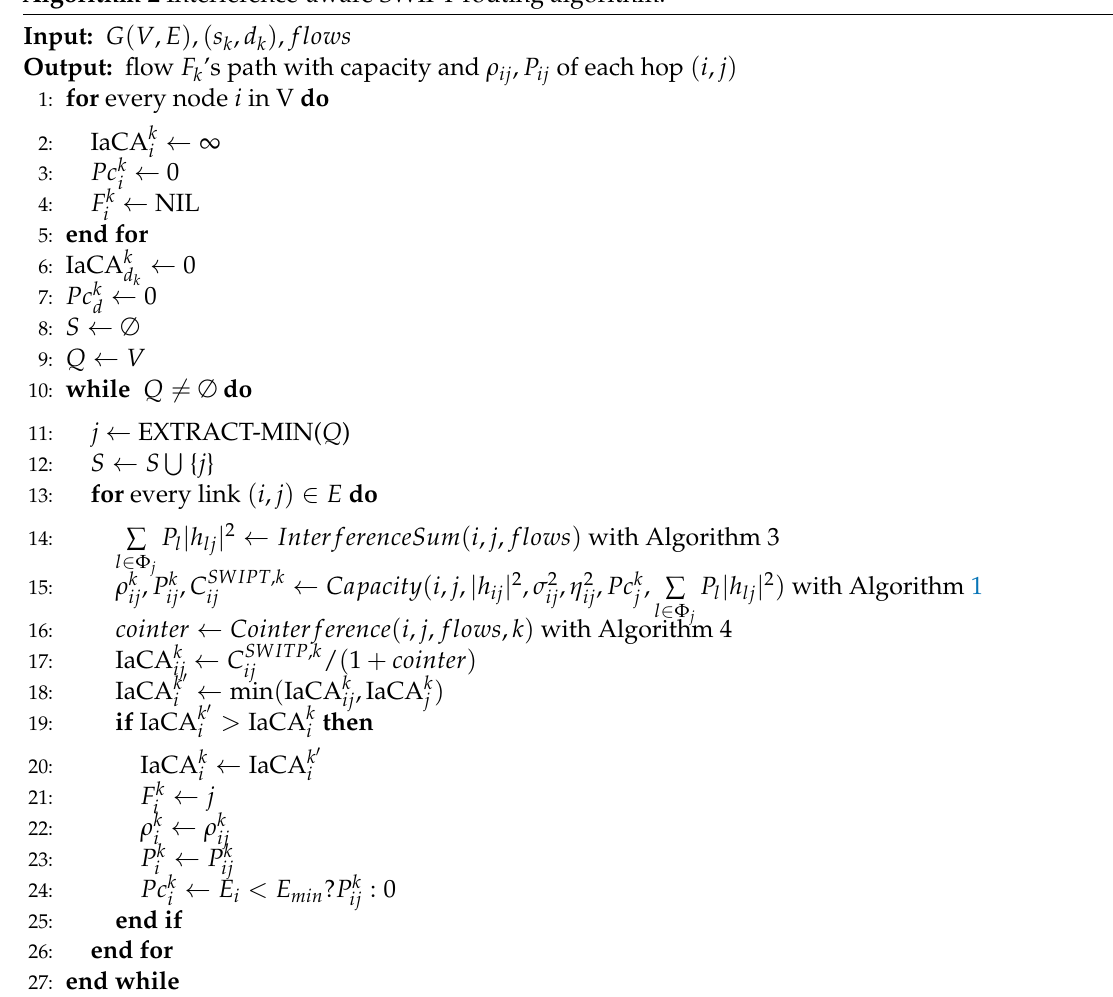
Algorithm 2 Interference-aware SWIPT routing